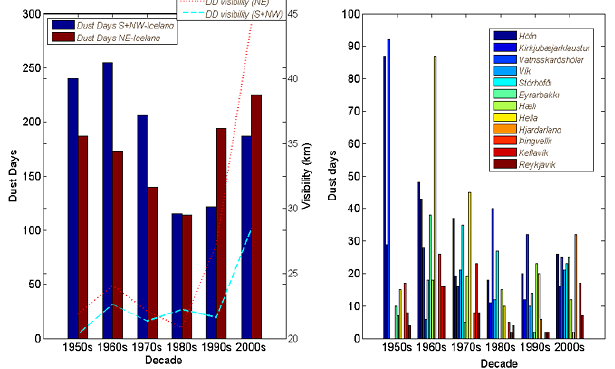
Figure 4. Number of dust days per month (bars) and monthly means of dust visibility (line) in the southern part of Iceland,